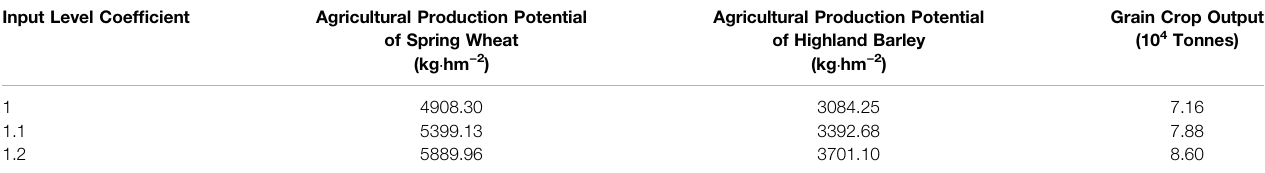
TABLE 4 | Agricultural production potential and grain yield under different input level coef fi cients.